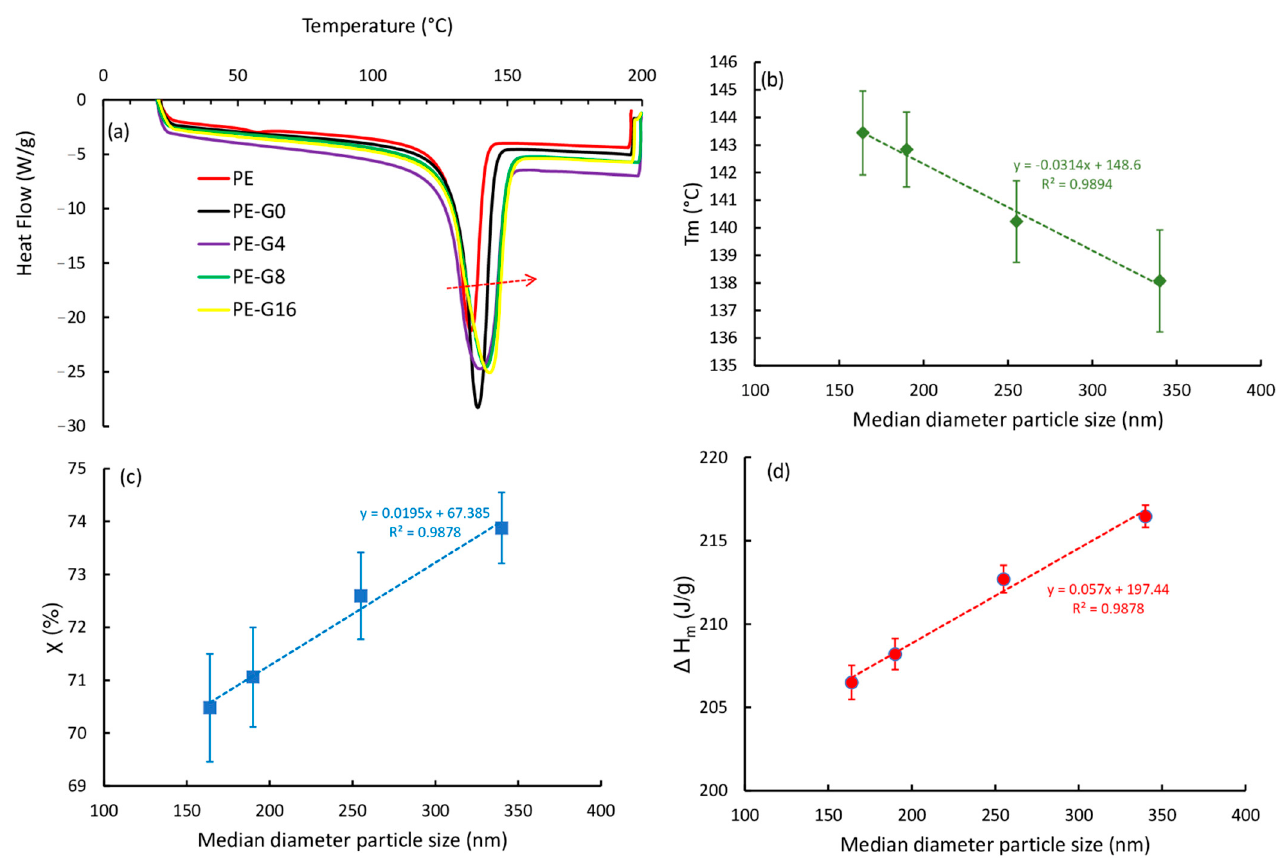
Figure 7. Differential scanning calorimetry (DSC) analysis of the pure HDPE and its composites with graphite ball milled at different times: ( a ) calorimetric curves; ( b ) melting temperature vs. median particle diameter; ( c ) crystalline degree vs. median particle diameter; ( d ) melting enthalpy vs. median particle diameter.